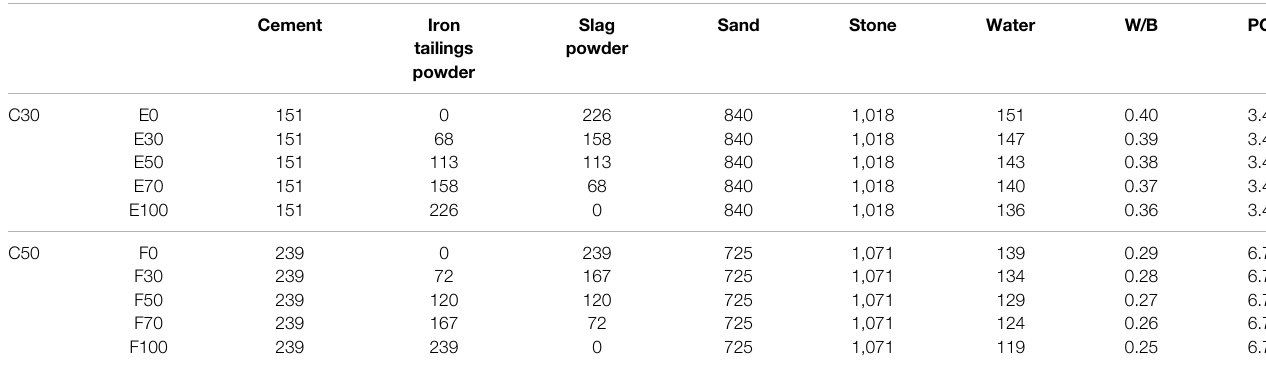
TABLE 6 | Mix proportion of veri fi cation concrete (kg · m − 3 ). Cement